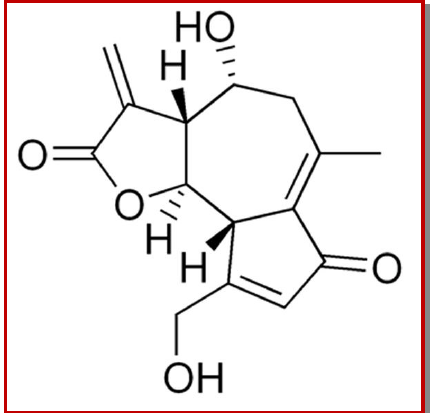
Figure 1: Chemical structure of lactucin